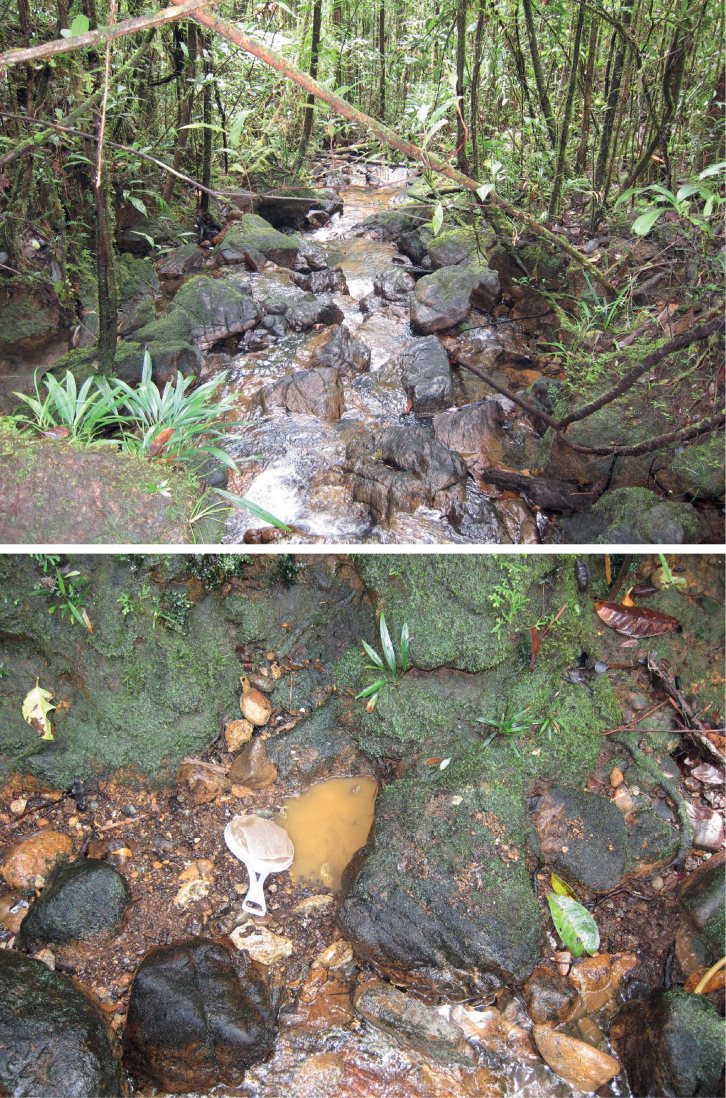
Habitat of Exocelina irianensis sp. n.: Indonesia, Papua Province, Nabire-Enarotali Road, 55th km, stream on the steep slope of the montane forest with the heavy red clay, mossy boulders, and abundant rough sand/gravel that being characteristic for this area (Mount Gamey).